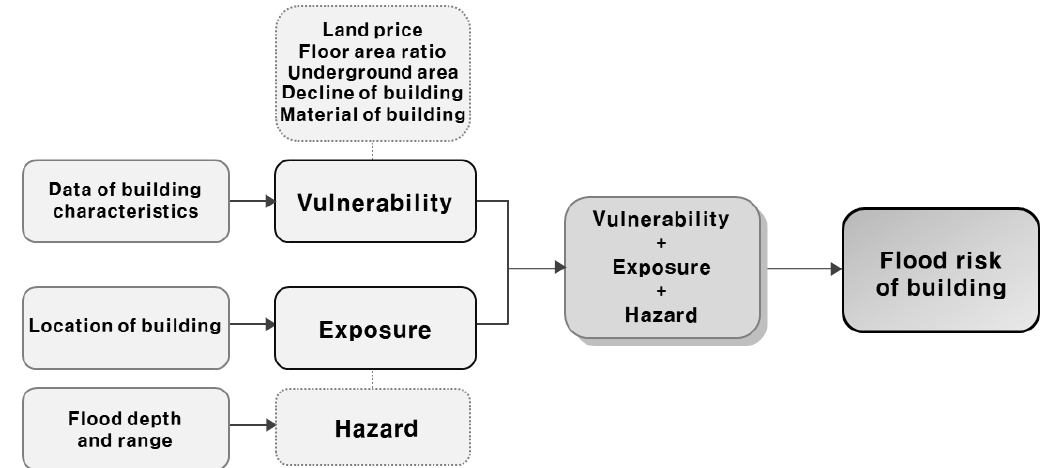
Figure 5. Analysis framework of flood risk building.